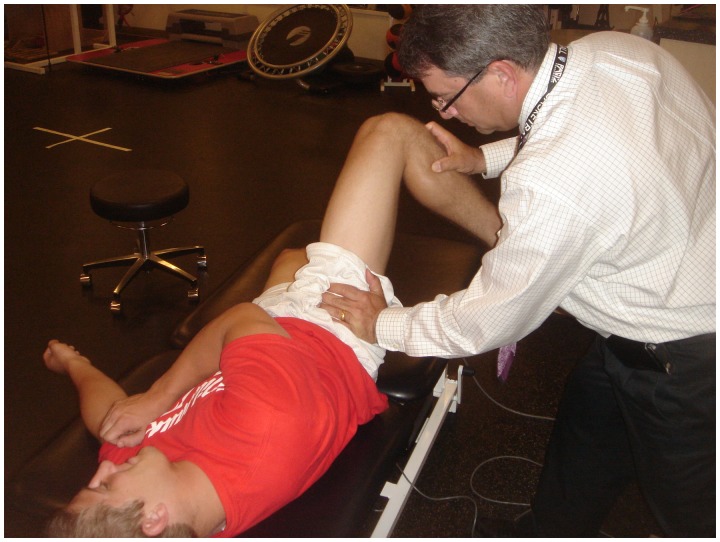
Abduction-extension-external rotation test. With this test of anterior instability, the patient is placed in the lateral decubitus position with the affected side up, abducted to 30° and externally rotated. An anteriorly directed pressure is placed on the posterior greater trochanter and the leg is slowly extended from 10° of flexion to full extension with a positive test reproducing the patient’s symptoms.